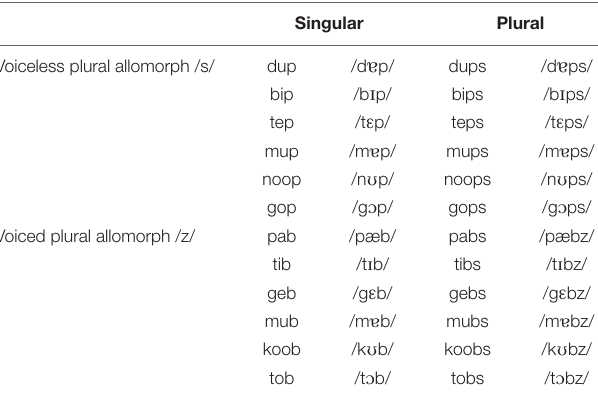
TABLE 2 | Segmental plural test block nonce words (segmental plural allomorphs /s/ and